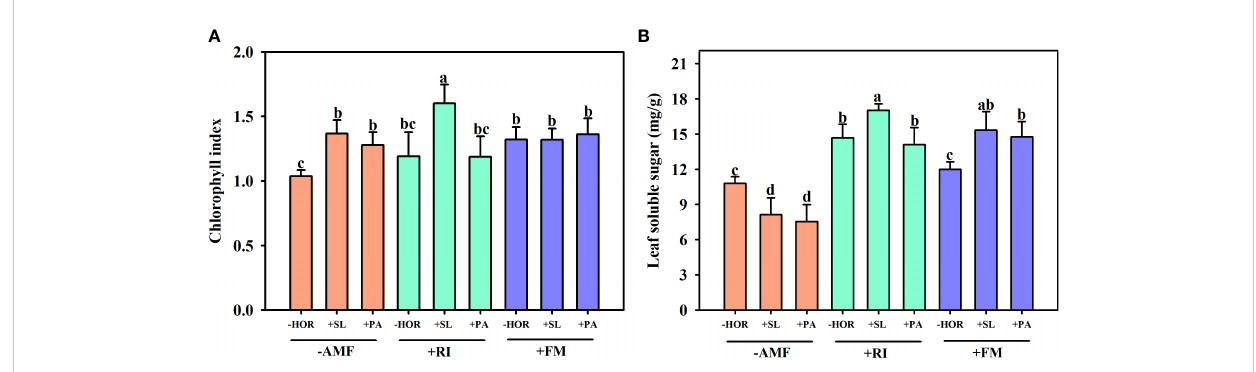
FIGURE 5 AMFs and plant hormones interaction had signi fi cant effects on chlorophyll indexes and soluble sugar contents in tea cutting seedings leaves. Effects of AMFs and hormones on (A) total chlorophyll index and (B) leaf soluble sugar content. Different lowercase letters in a fi gure indicate that the mean values are signi fi cantly different (P < 0.05) from each other according to LSD